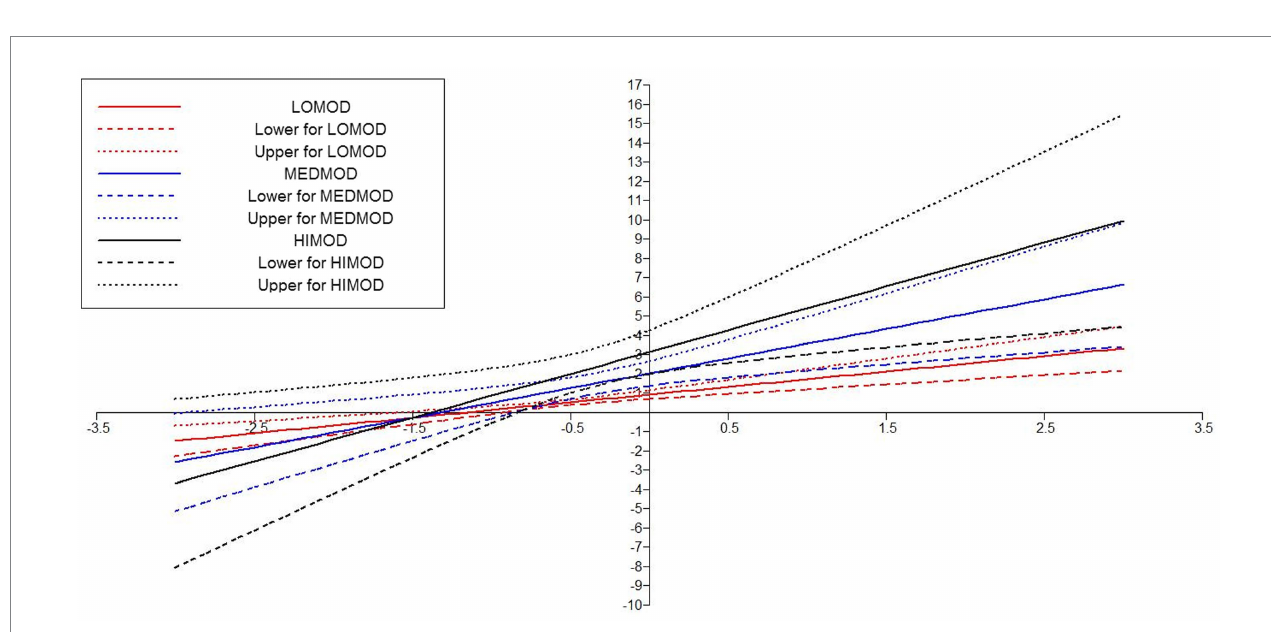
FIGURE 8 Interaction plot showing the moderating effect of TESOL amplified communication apprehension on informal education—entrepreneurial behavior